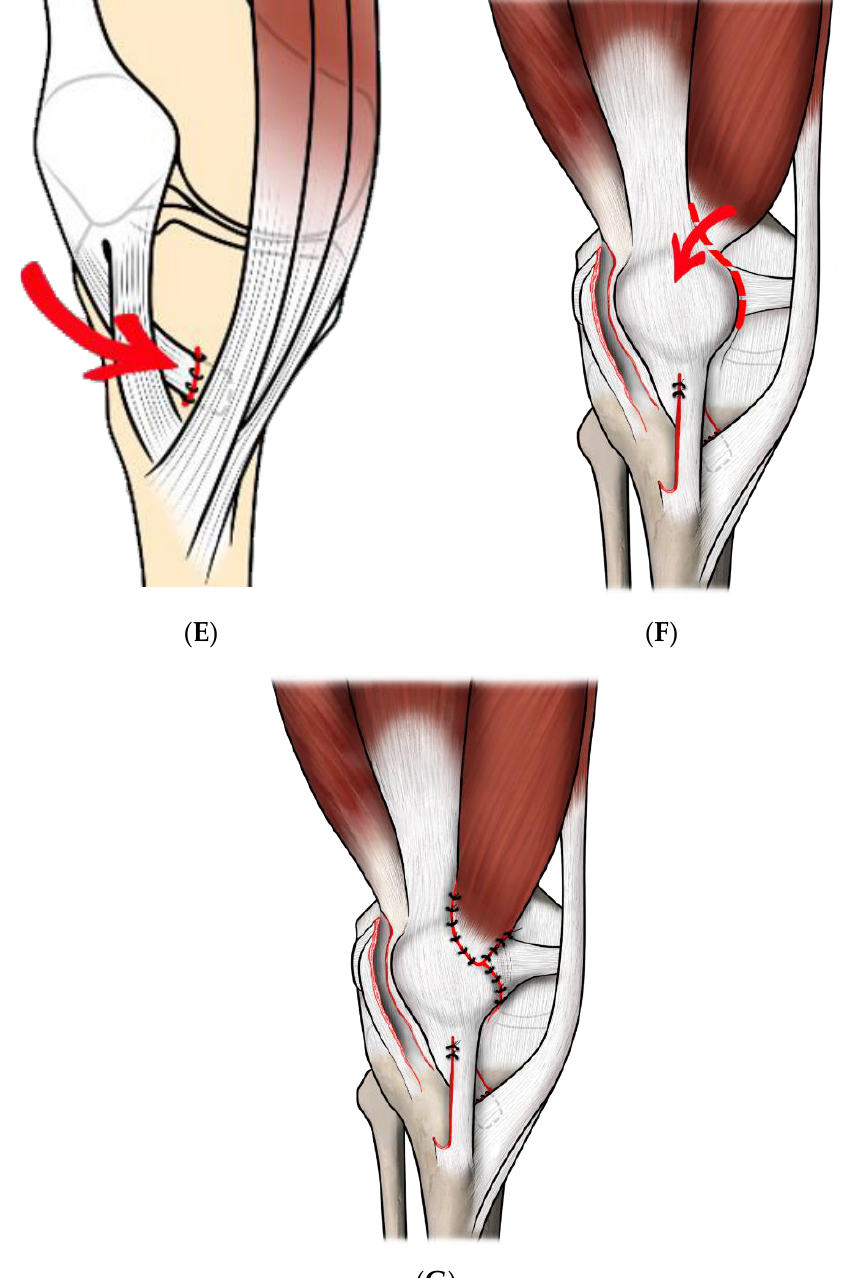
Figure 1. ( A ) lateral parapatellar incision; ( B ) extensive lateral retinacular release; ( C ) the patellar tendon was split longitudinally (red arrow); ( D ) the lateral half was detached from its distal insertion and passed medially; ( E ) the lateral half was sutured in a pouch of periosteum, under the pes anserinus (red arrow); ( F ) the vastus medialis obliquus was detached from the quadriceps tendon, and the medial capsule was dissected; ( G ) the vastus medialis obliquus and the medial capsule were transferred distally and laterally to the anterior surface of the patella (red arrow).